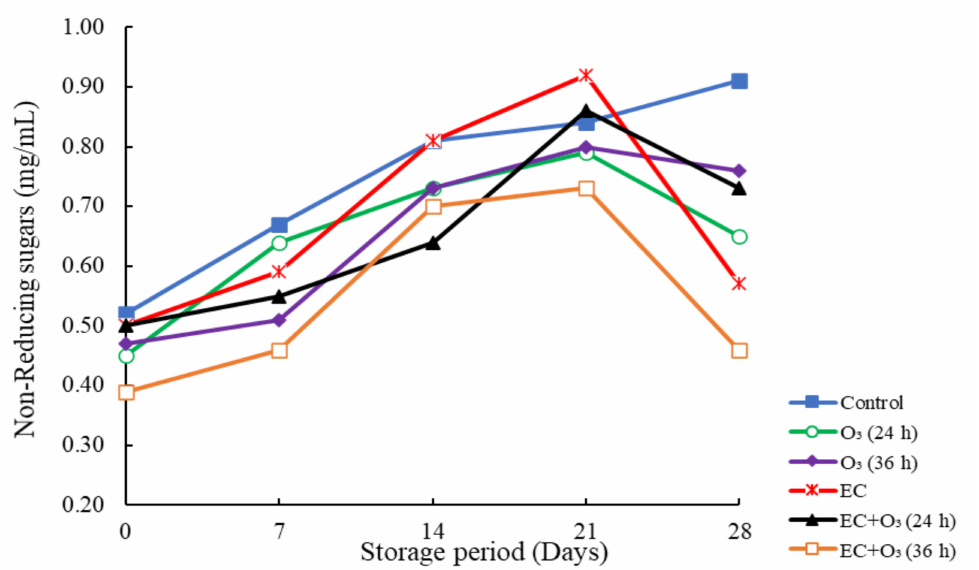
Figure 7. Effect of edible coating (EC) and gaseous ozone (O 3 ) on non-reducing sugars of mango fruit during storage at 10 ◦ C for twenty-one days and shelf-life at ambient temperature for seven days ( ± SE, n = 9).